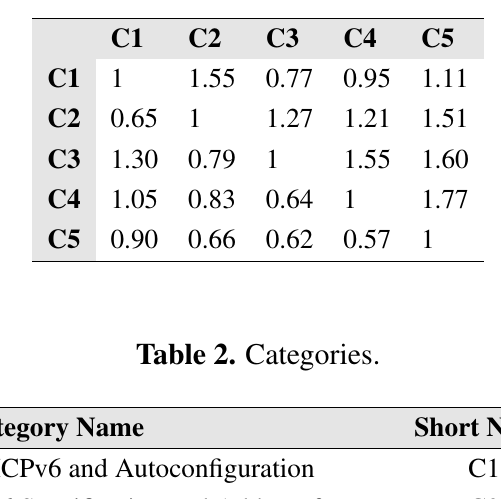
Table 1. Aggregated (average) comparison matrix (n = 34).